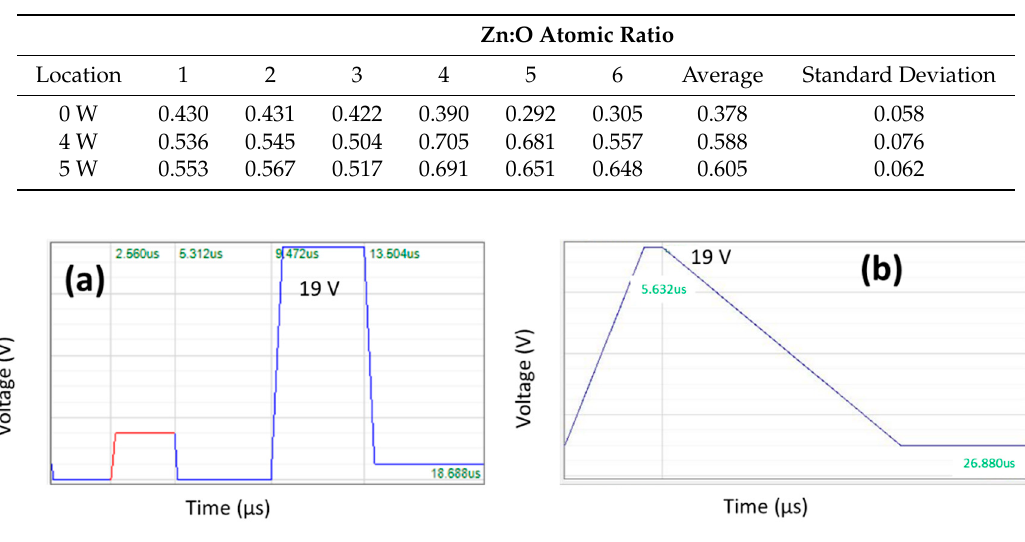
Figure A1. Waveform of signal applying to cartridge nozzles to create jetting of ink: ( a ) silver ink and ( b ) zinc salt ink.